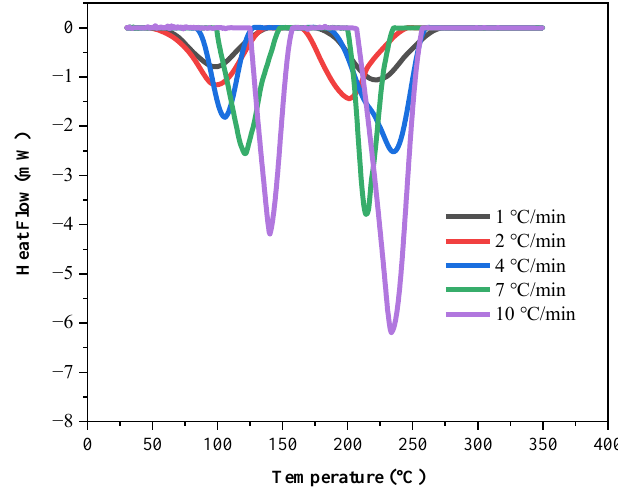
Figure 2. Endothermic curves of LP30 + PFPN at different heating rates.